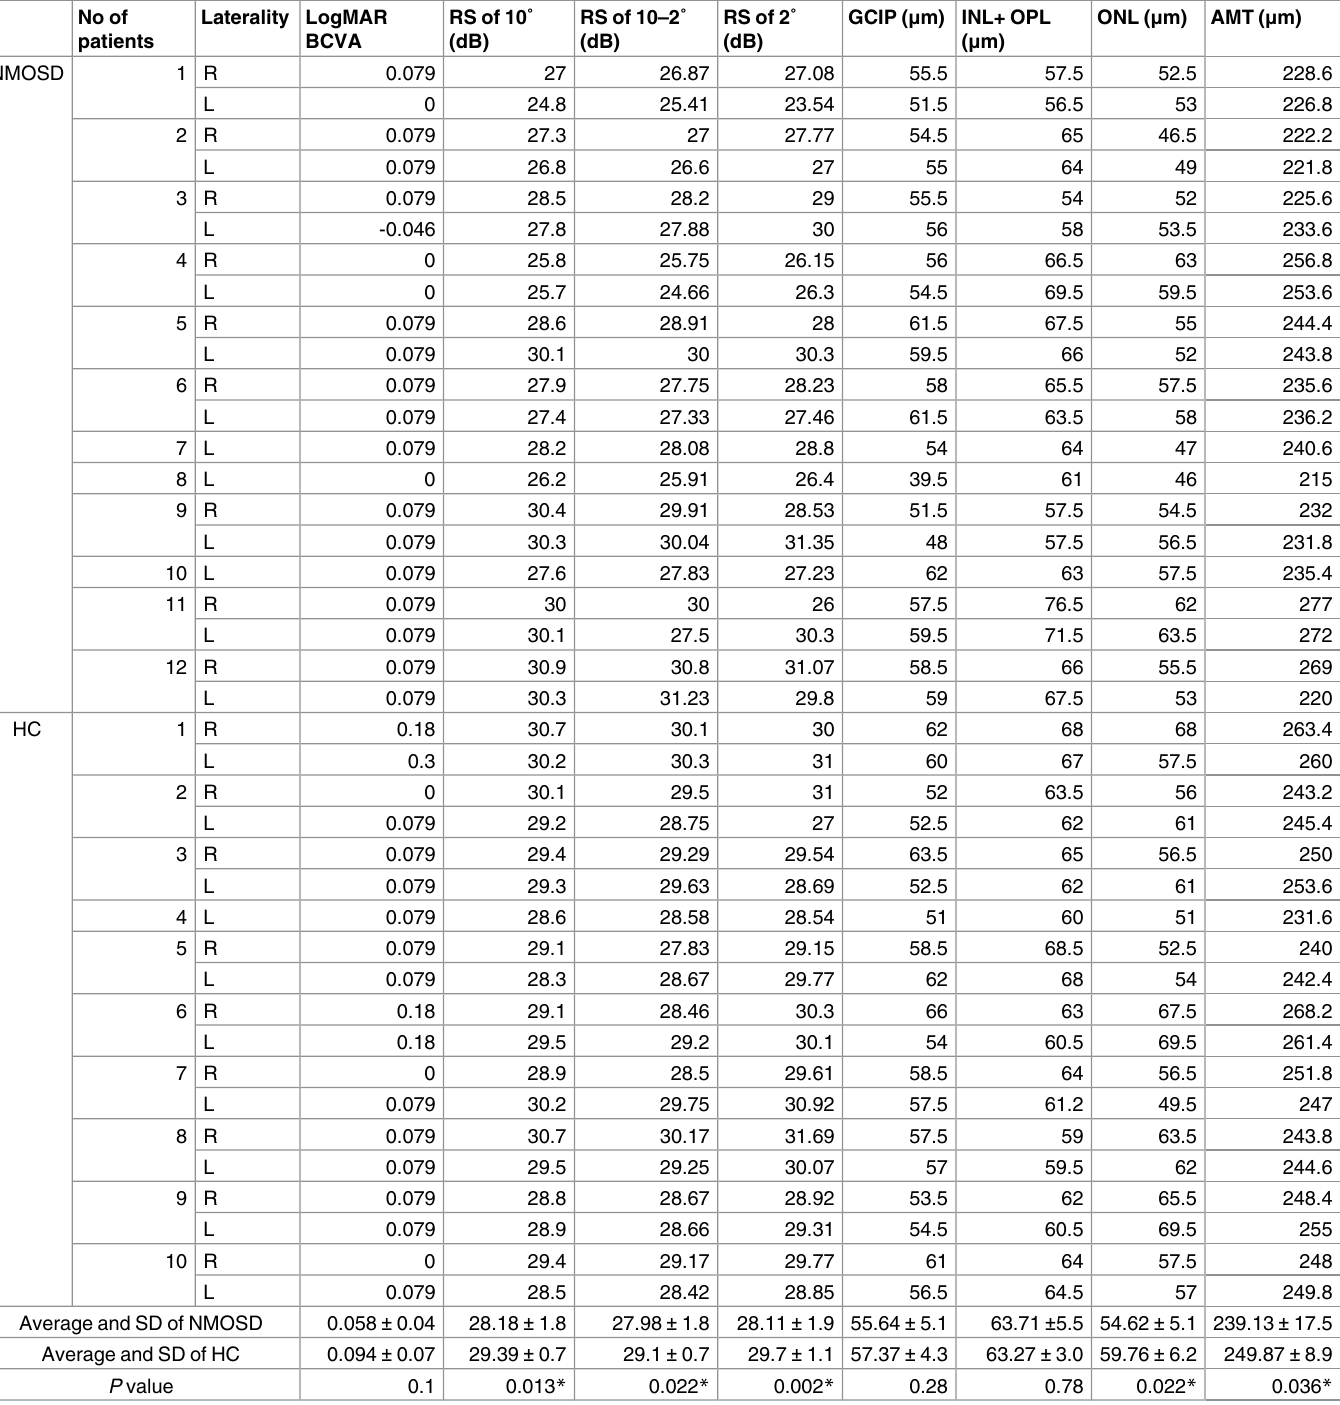
Table 2. Result of optical coherence tomography and visual function tests. No of